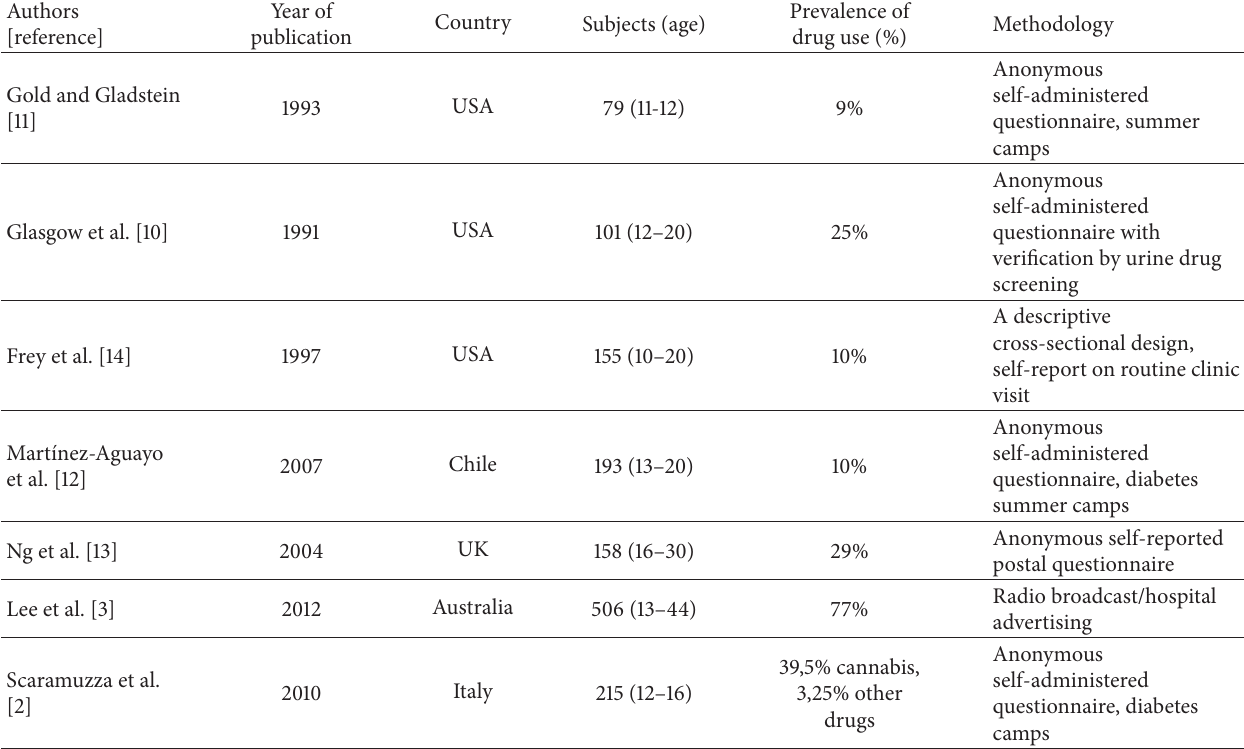
Table 4: Prevalence of illicit drug use in young people with type 1